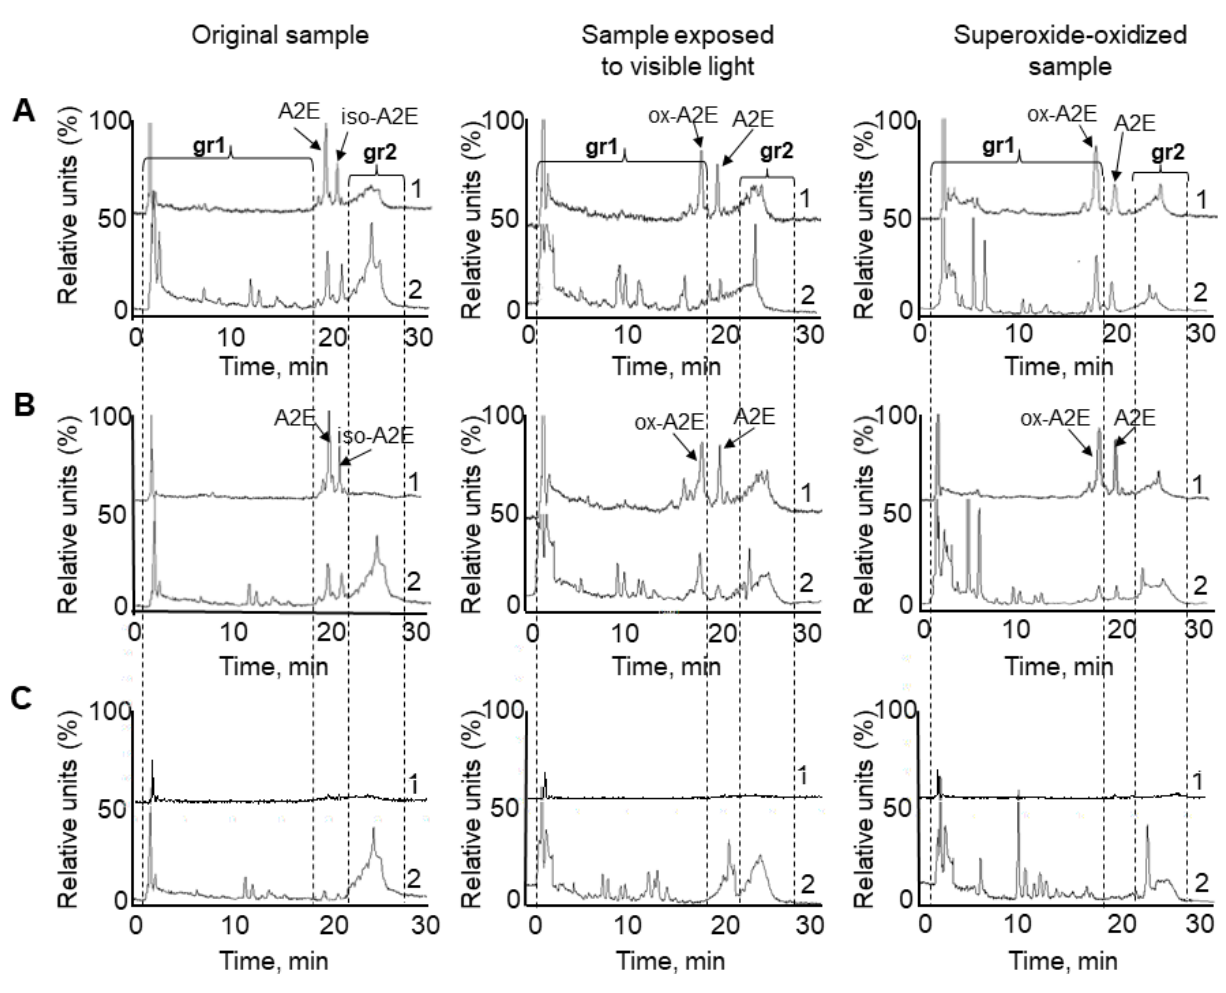
Figure 3. HPLC analysis of chloroform extracts from the studied samples in Figure 1. ( A ) lipofuscin granule (LG) suspension, ( B ) LG sediment, and ( C ) supernatant. Vertical dotted lines indicate groups of peaks: (gr1), group of peaks corresponding to BisRet-OX, containing mono- and bis-oxy A2E; and (gr2), group of peaks corresponding to bisretinoids and their oxidized forms. Detection at wavelengths of 430 nm (1) and 365 nm (2).